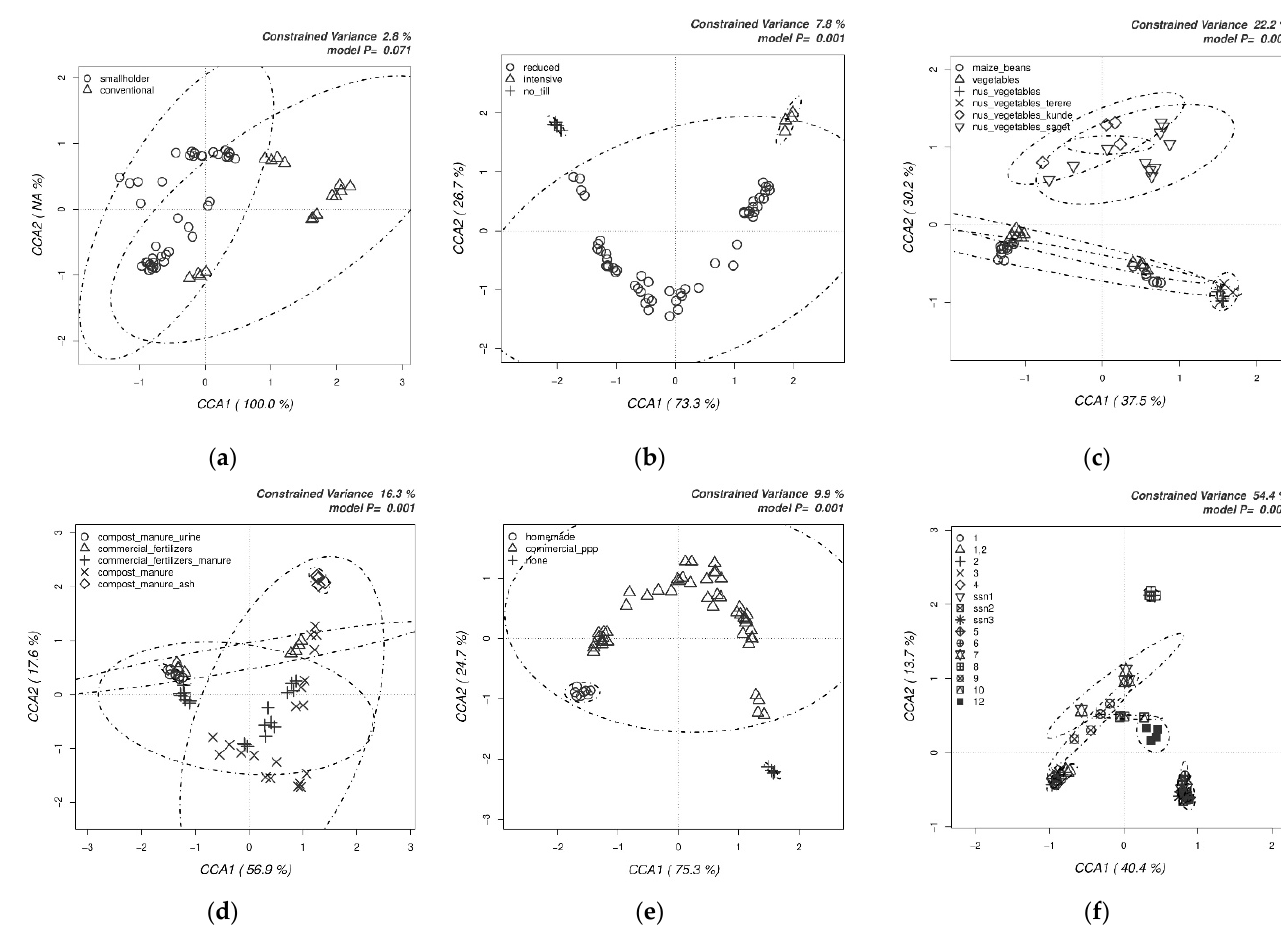
Figure 3. Canonical correspondence analyses (CCAs) on the impact of the farm management choices on the structure of bacterial communities. This was determined by the relative abundances of all the OTUs obtained by Illumina sequencing of bacterial 16S amplicons.